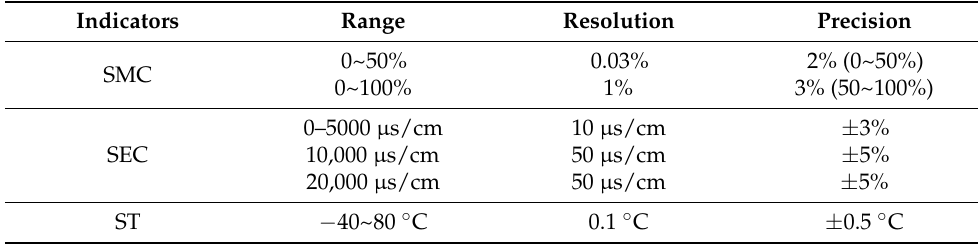
Table 1. Parameters of NECMEC20